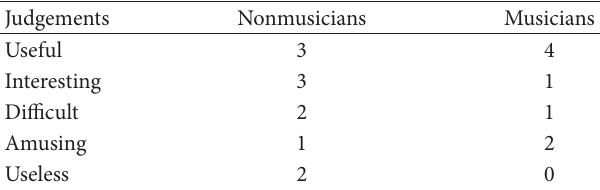
Table 8: Table of the subjects’ ideas about the